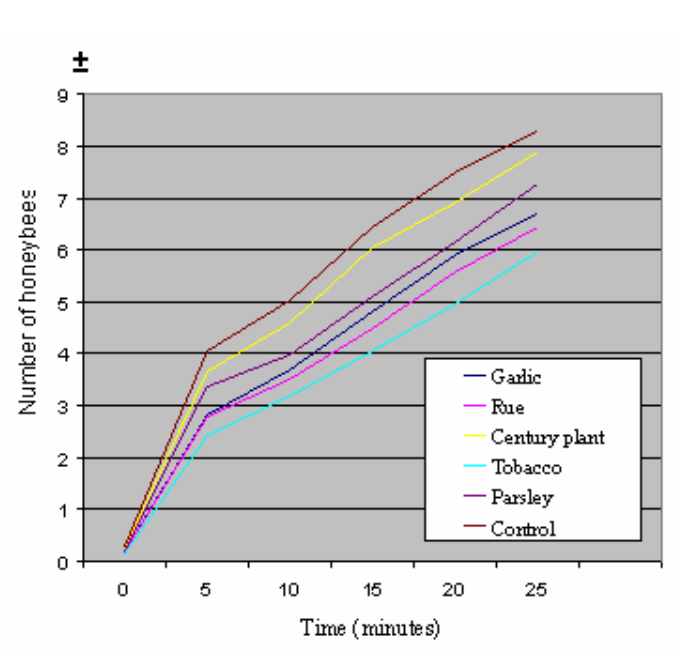
Figure 1 . Average number of honeybees in the in vitro tests after extract